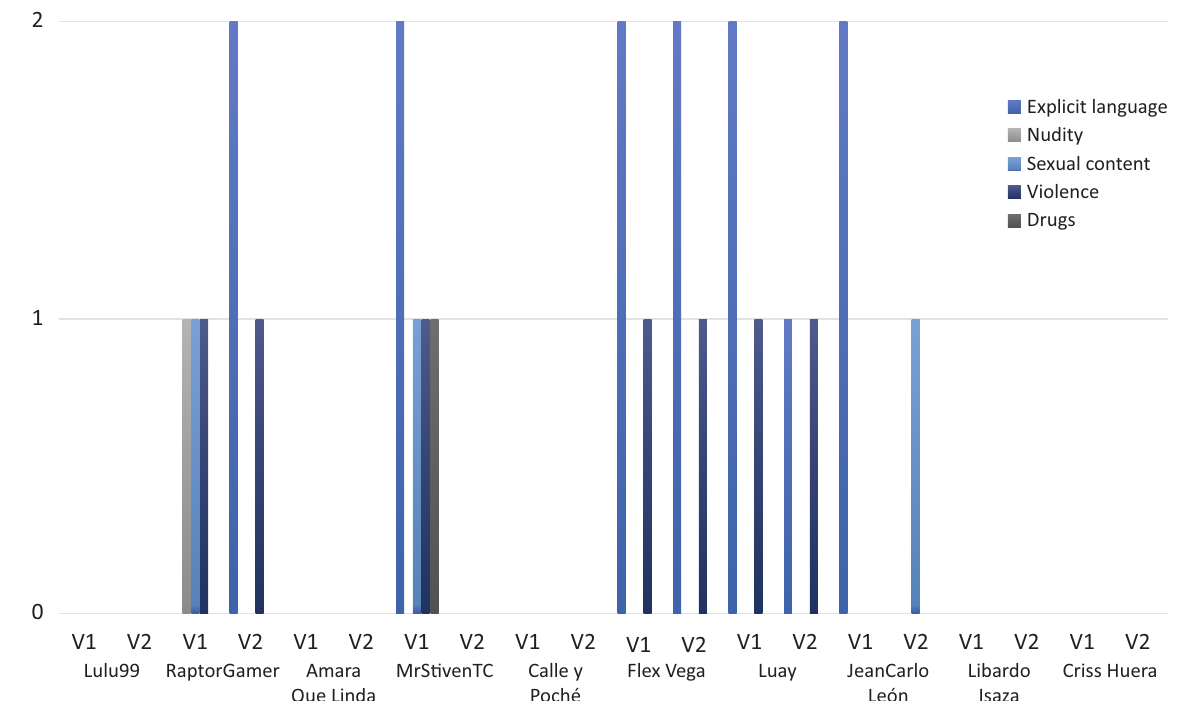
Figure 2. Content classification of YouTubers in the Andean Community. and it confirms what was stated by Feixas et al. (2014),